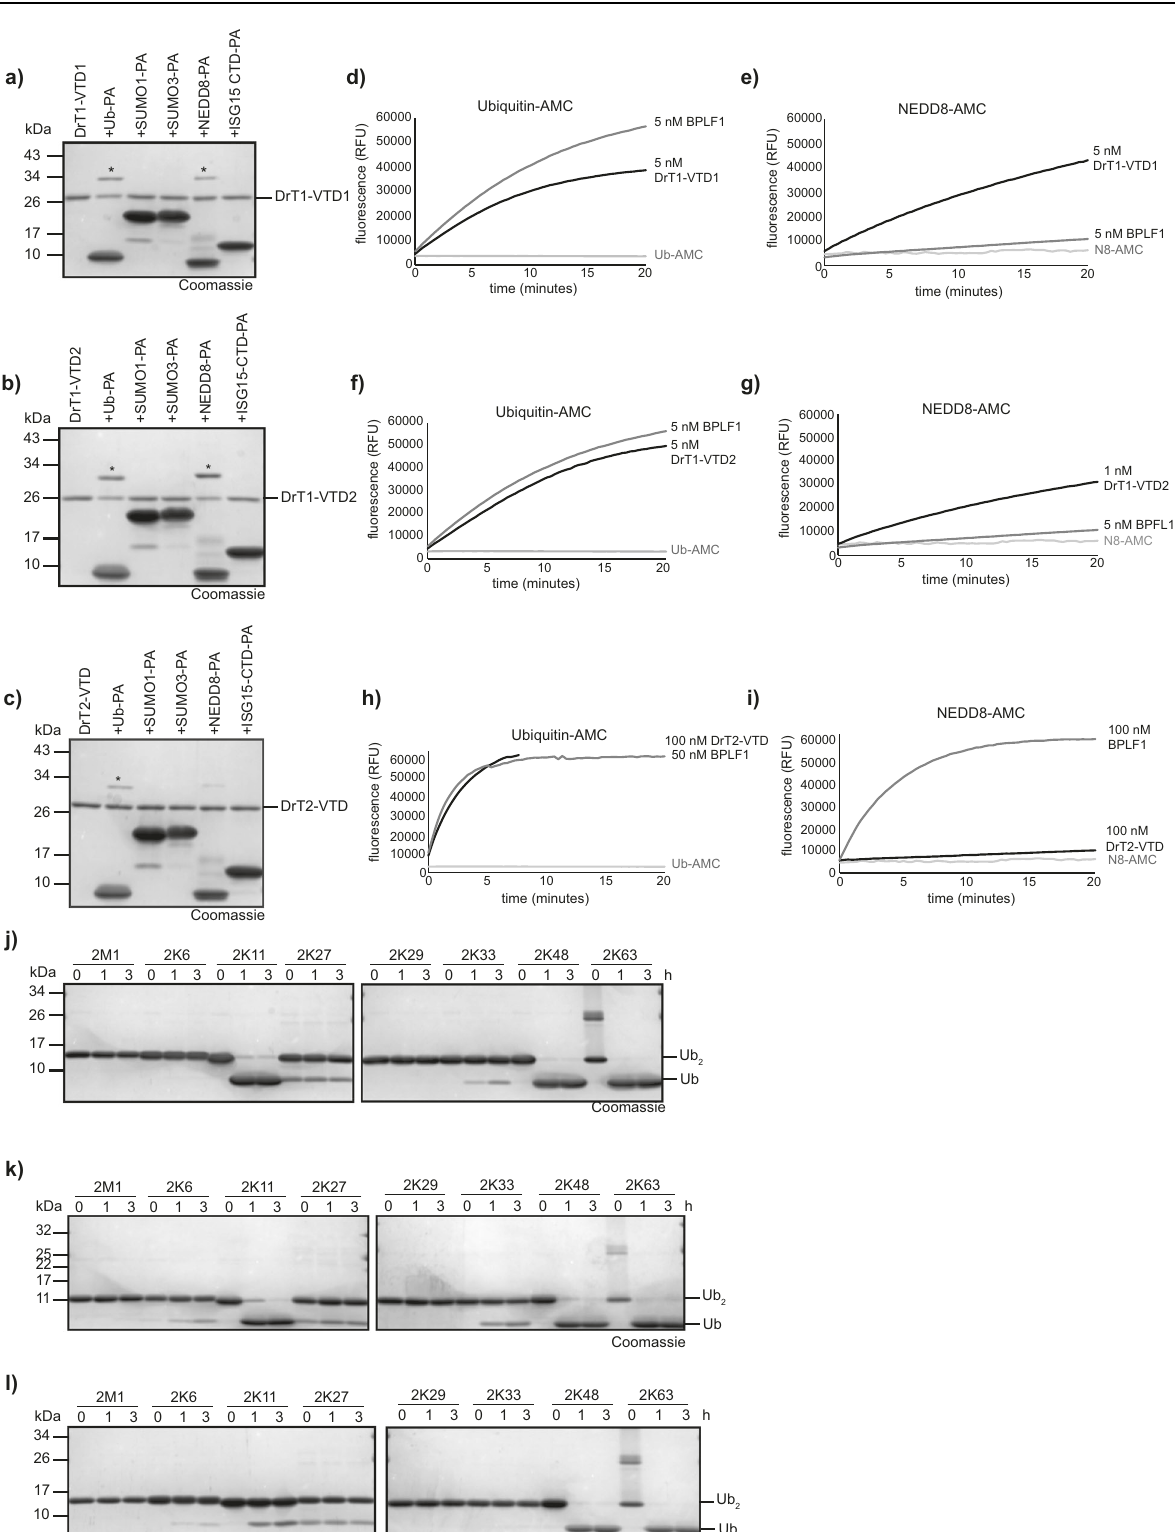
Fig. 2 | Activity of Helitron-encoded VTDs. a – c Reaction of DrT1-VTD1 ( a ), DrT1- VTD2( b )orDrT2-VTD( c )withUbandUblactivity-basedprobes.Asterisksmarkthe shifted bands after reaction. d , e Activity of 5nM DrT1-VTD1 or BPLF1 against Ubiquitin-AMC ( d ) and NEDD8-AMC ( e ). The RFU values are the means of tripli- cates. f , g Activity of 5nM DrT1-VTD2 or BPLF1 against Ubiquitin-AMC ( f ) and 1nM Dr1VTD2 against NEDD8-AMC ( g ). The RFU values are the means of triplicates.